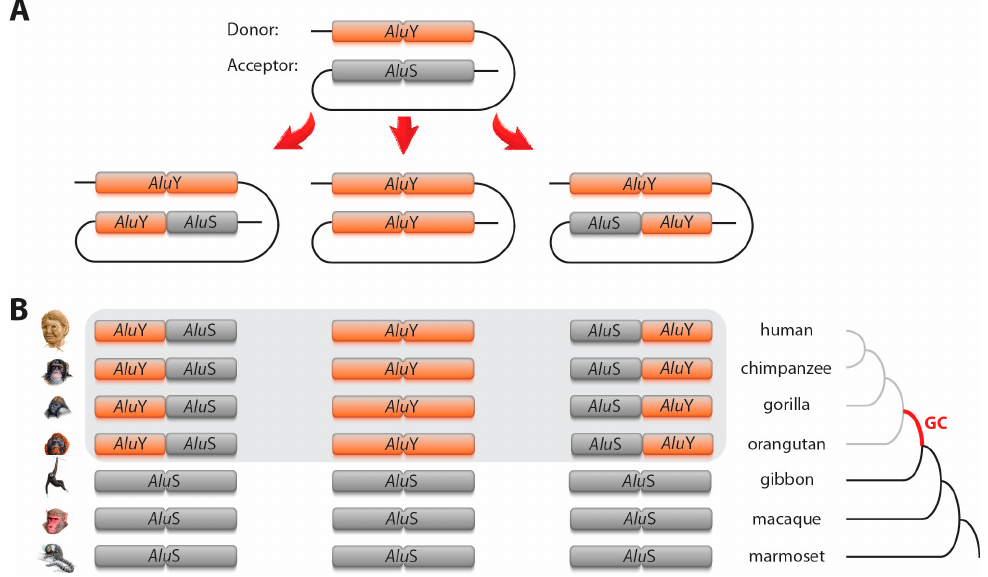
Figure 1. Schematic representation of Alu – Alu gene conversion. ( A ) shows three different scenarios of gene conversion: in which a 5 ′ -end Alu monomer, a complete Alu , or a 3 ′ -end Alu monomer were converted. ( B ) Representative gene conversion at orthologous Alu S loci leading to 5 ′ -end Alu Y, Alu Y, and 3 ′ -end Alu Y in the common ancestor of great apes (grey area; e.g., loci Alu S_plus_7691_7692, HGib37, and H_ Alu S6 in Supplementary Table S1 and Supplementary File S2, ignoring some variation in marmoset). The phylogenetic time-point of gene conversions is labelled GC (red branch of the